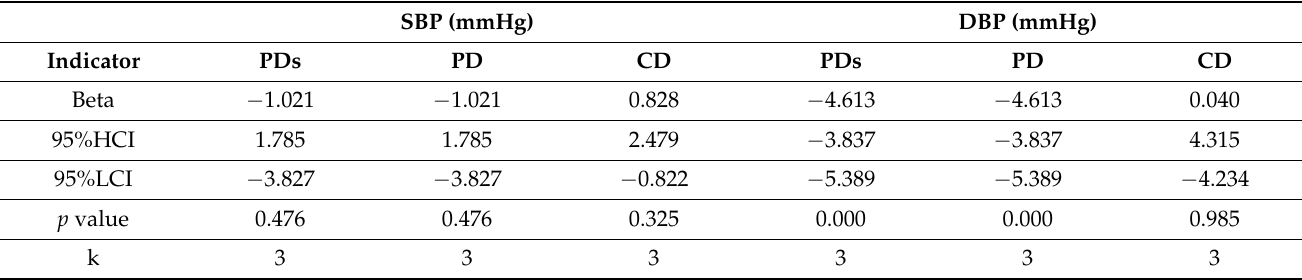
Table 7. Changes in blood pressure (systolic blood pressure and diastolic blood pressure) in long-term PDs, PD, and CD studies (over 6